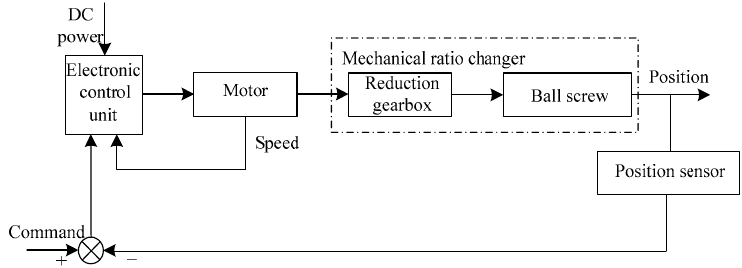
Figure 6. Structural diagram of the electromechanical actuator.